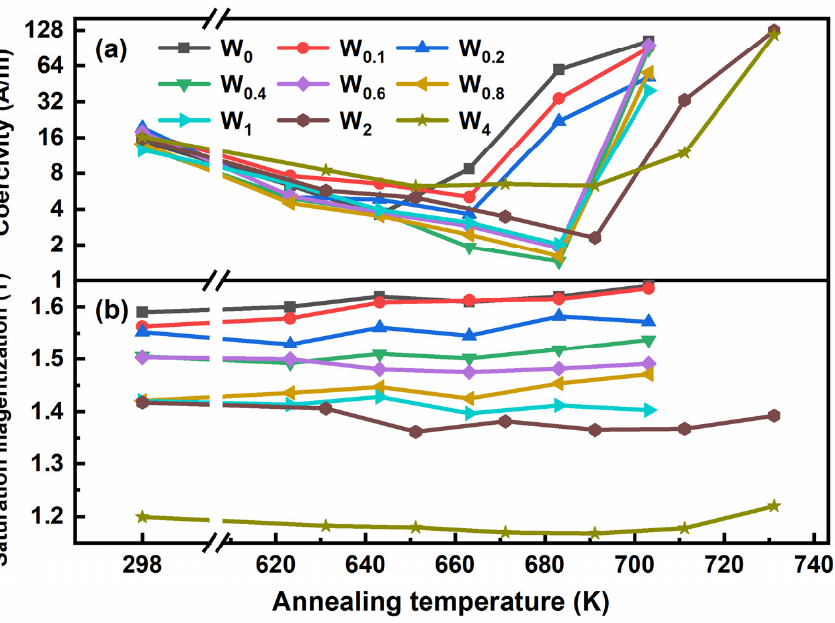
Figure 2. Annealing temperatures dependence of ( a ) H c and ( b ) B s for Fe 86 − x P 11 C 2 B 1 W x alloy ribbons. Table 2. The H c and B s values of Fe 86 − x P 11 C 2 B 1 W x alloys annealed at optimal temperature for 10 min.